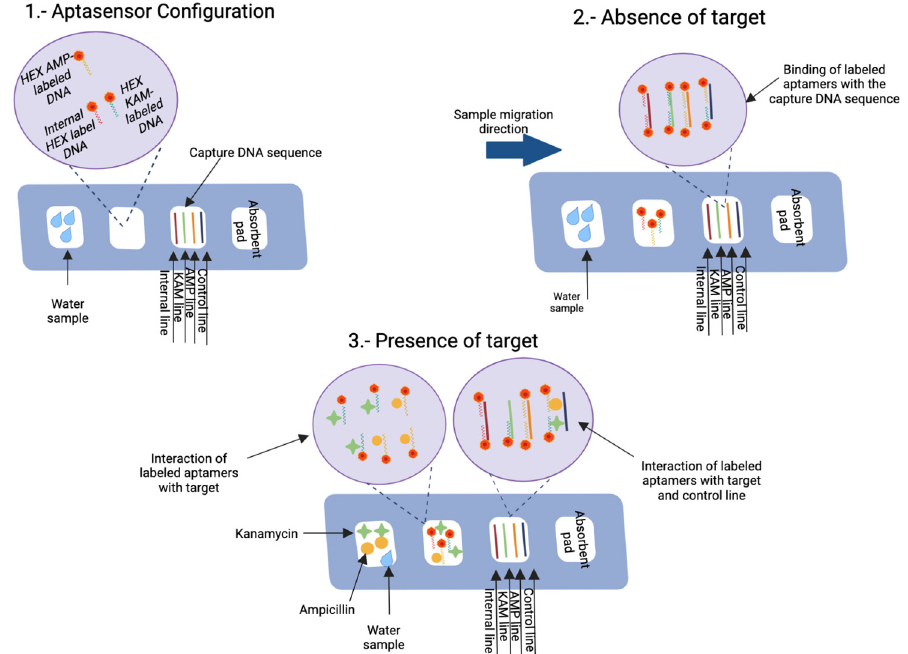
Figure 8 . Schematic representation showing the setup and operation of an aptamer-based rapid test for the simultaneous detection of ampicillin (AMP) and Kanamycin (KAM). ( 1 ) The aptamer-based rapid test consists of four sections: in the first section, the sample is loaded; in the second section, the labeled aptamers that recognize the positive control (internal line) are located; the third section contains DNA sequences immobilized with biotin to capture the labeled aptamers; the fourth section consists of an absorbent pad. ( 2 ) In the absence of the target, the loaded sample in the first section migrates by capillarity to the second section, in which the labeled aptamers are located; they move to the third section, where the DNA sequences capture their corresponding aptamers. The internal line traps the internal HEX label DNA, the KAM line captures HEX KAM-labeled DNA, the AMP line captures HEX AMP-labeled DNA, and the control line captures some of the remnants of the HEX KAM-labeled DNA, and HEX AMP-labeled DNA aptamers. ( 3 ) In the presence of the target, the sample migrates from section one by capillarity to the second section where the KAM and AMP targets bind to their HEX-AMP-labeled DNA and HEX AMP-labeled DNA aptamers, respectively. In section three, these target-bound aptamers are captured in the control line, while free aptamers are bound in the AMP and KAM lines. Therefore, the control line signal is inversely proportional to the AMP and KAM lines. Created with